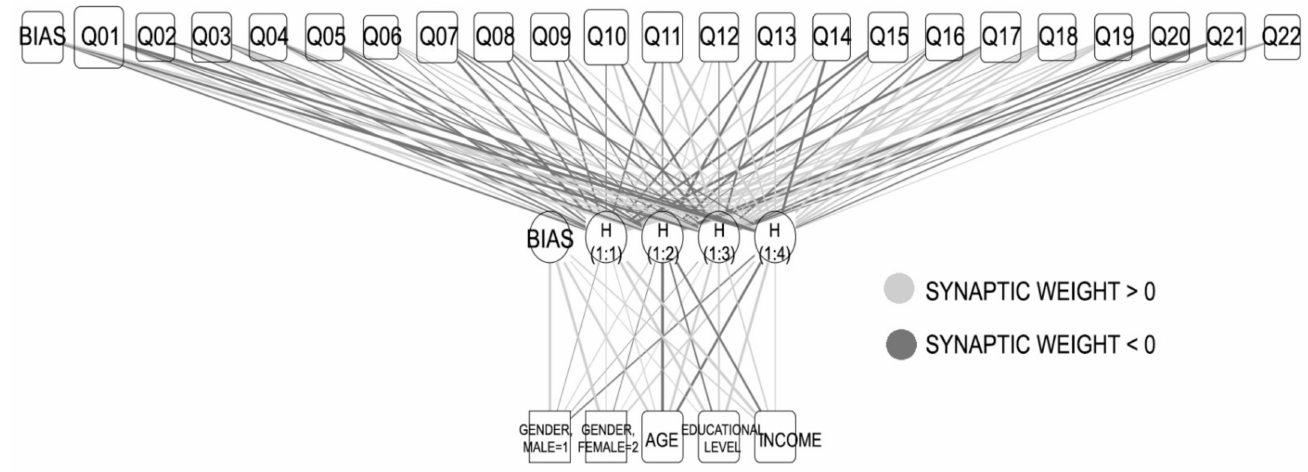
Figure 1. Graphic representation of the ANN obtained.